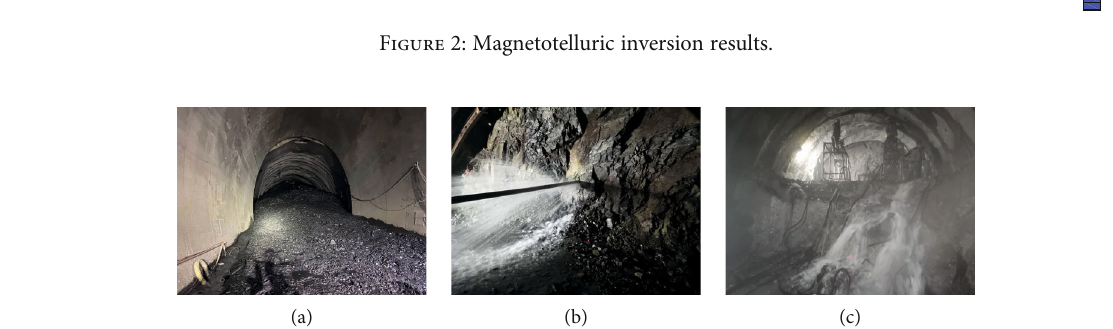
Figure 3: Water gushing and mud inrush in tunnels. (a) Mud inrush in tunnel. (b) Water inrush from advance probe hole. (c) Tunnel water